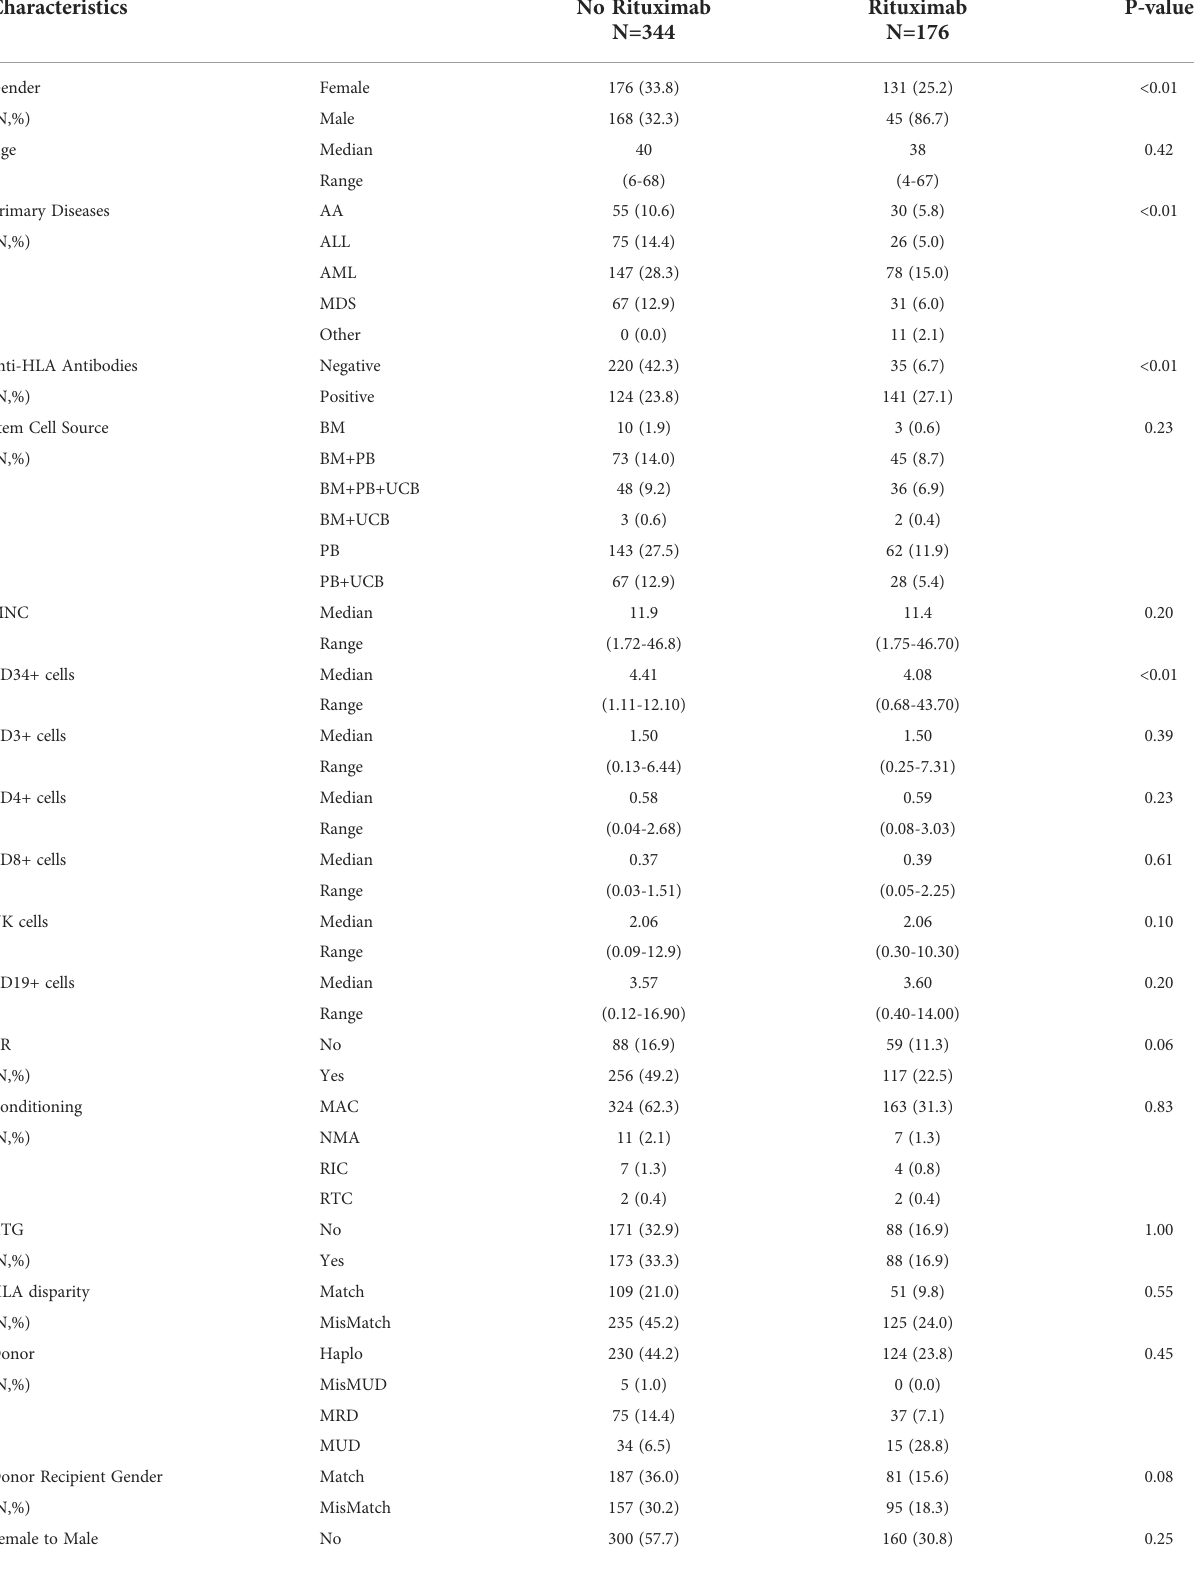
TABLE 1 Baseline characteristics of the entire cohort.